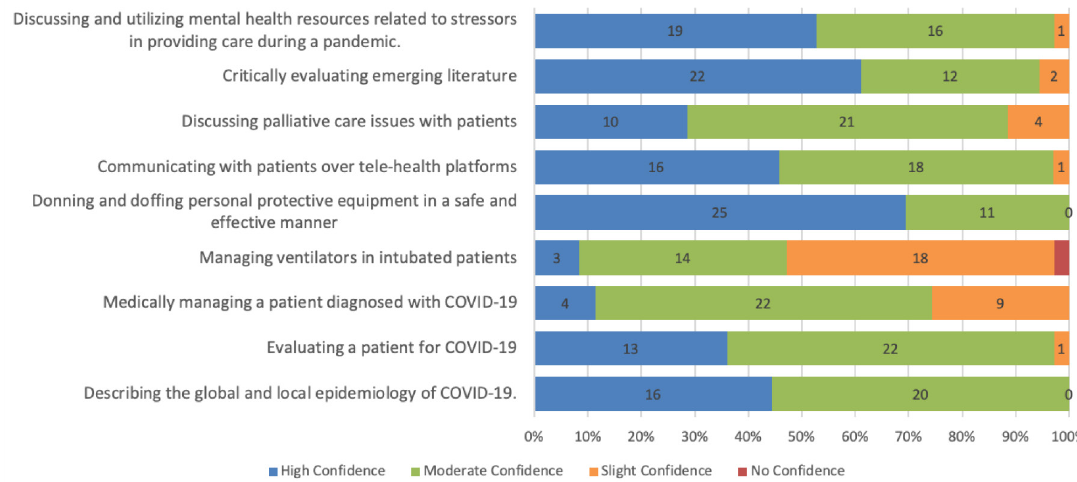
Figure 2. Post-course survey responses related to student confidence